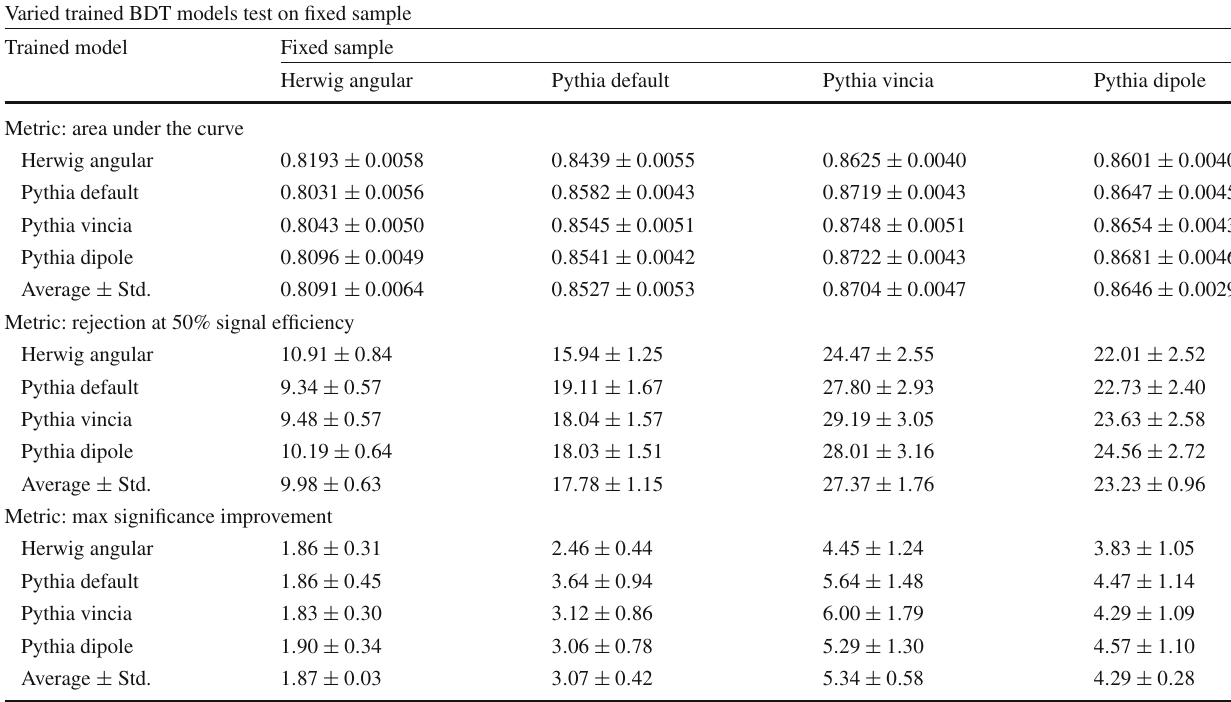
Table 5 Area under the curve, rejection at 50% signal efficiency and maximum significance improvement for the BDT model. The last rows are the average and standard deviation over the mean values from the other rows Varied trained BDT models test on fixed sample